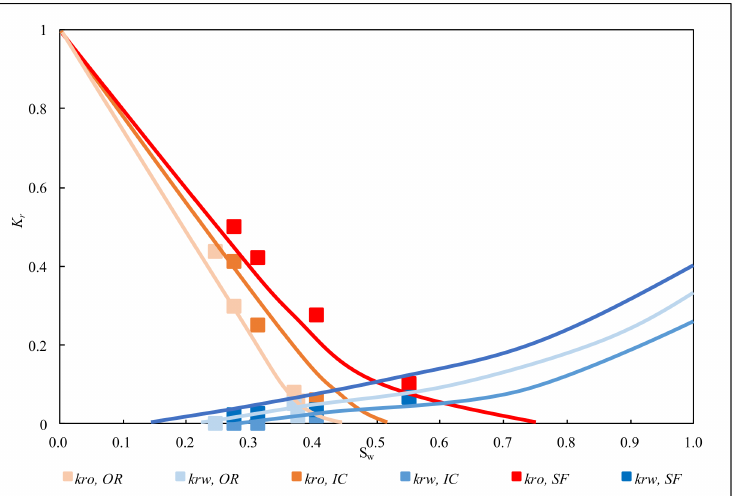
Figure 7. Comparison among the original relative permeability curve (OR), the relative permeability curve corrected by the intercept method (IC), and the stability factor method